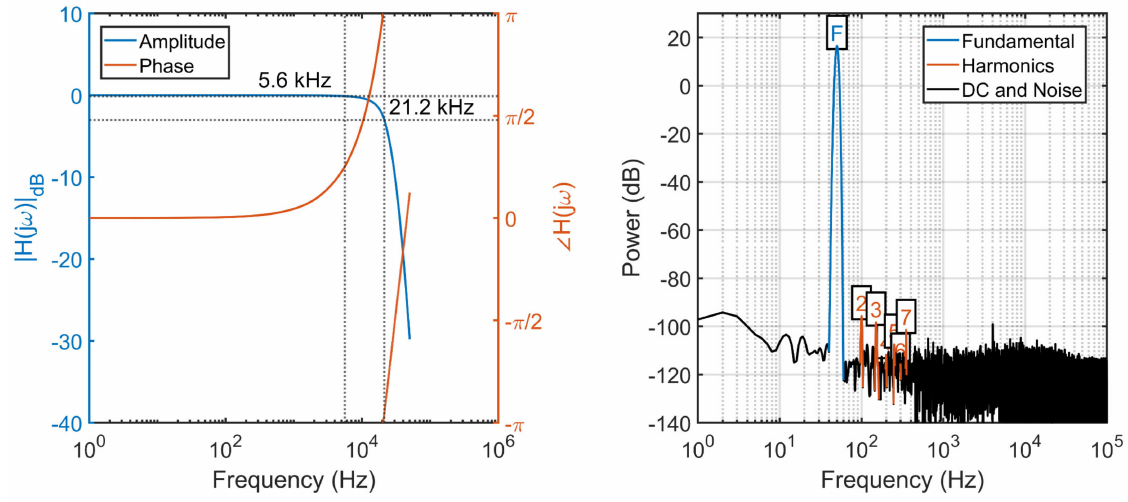
Figure 11. Frequency response ( left ) and power spectrum ( right ) at 50 Hz.